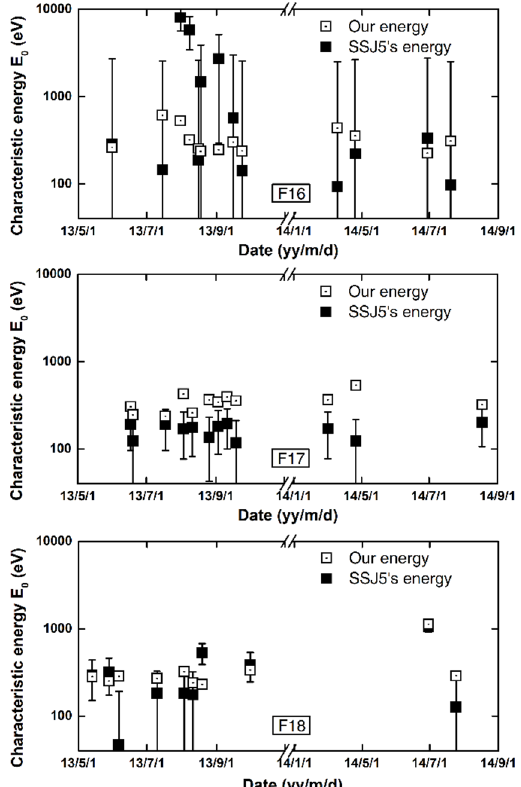
Figure 8. A bar plot of the estimations from both ASD and acquired data by SSJ5 with error bars representing their respective standard